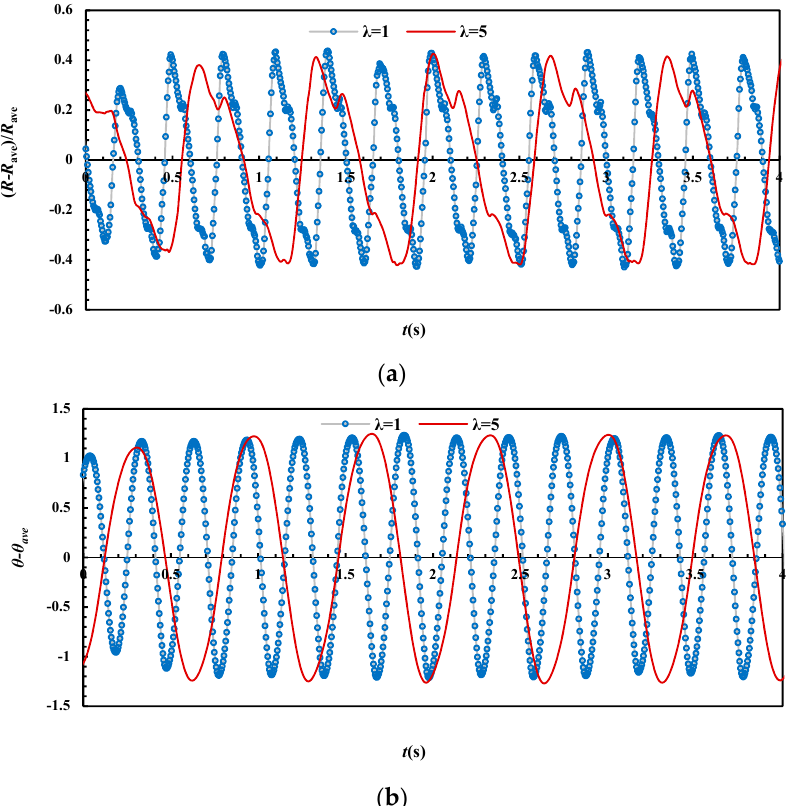
Figure 18. Oscillation characteristic of resistance and trim angle during porpoising: ( a ) resistance; ( b ) trim angle.